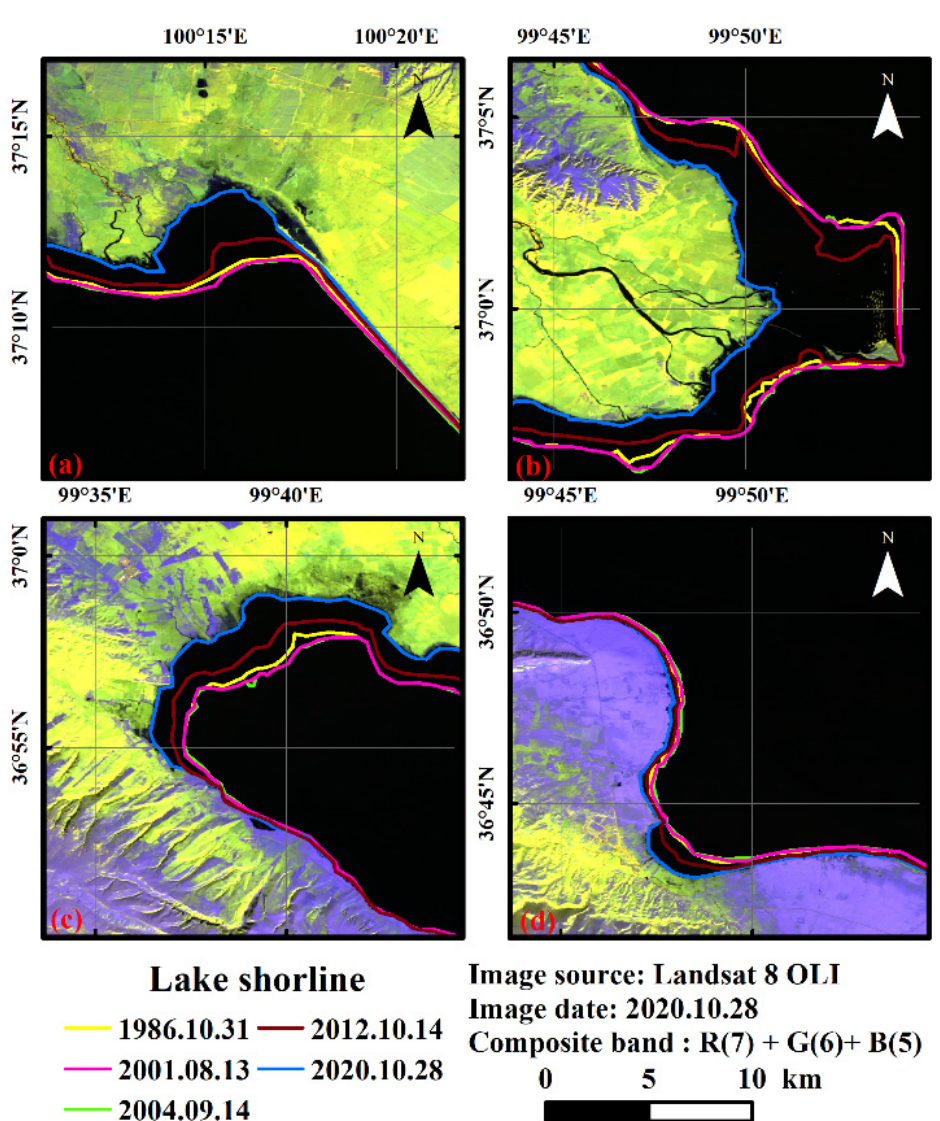
Figure 10. The shorelines of four estuaries of Lake Qinghai in 1986, 2001, 2004, 2012, and 2020. ( a ) Xian’nyu Bay; ( b ) Buha; ( c ) Shinaihai; ( d ) Heima.